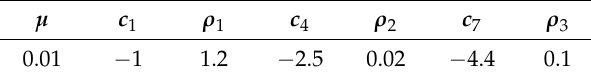
Table 3. The control parameters for simulation